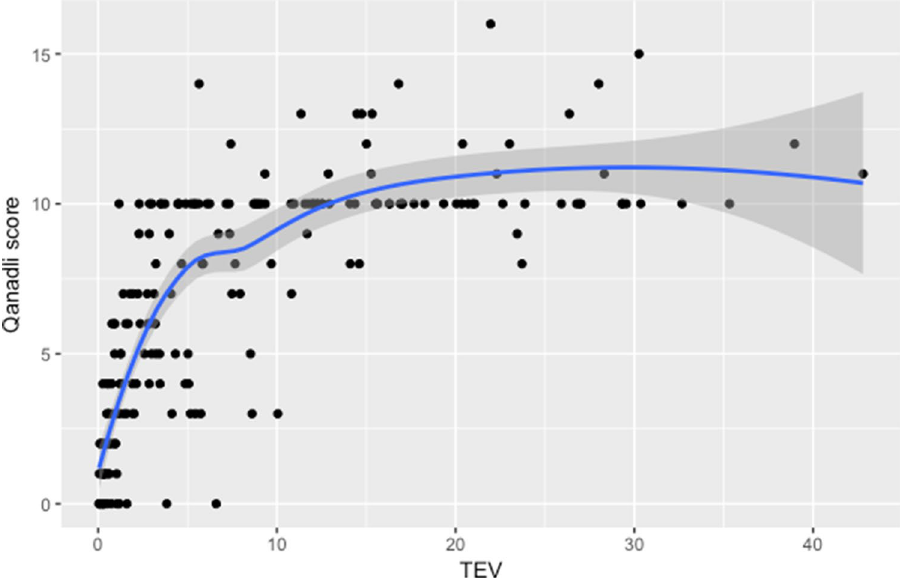
Figure 1. TEV V.S. Qanadli score. The correlation of the TEV and Qanadli score (r = 0.69, p < 0.001). However, the correlation did not seem to be linear. The regression line was drawn using the LOESS method (Local Polynomial Regression Fitting).